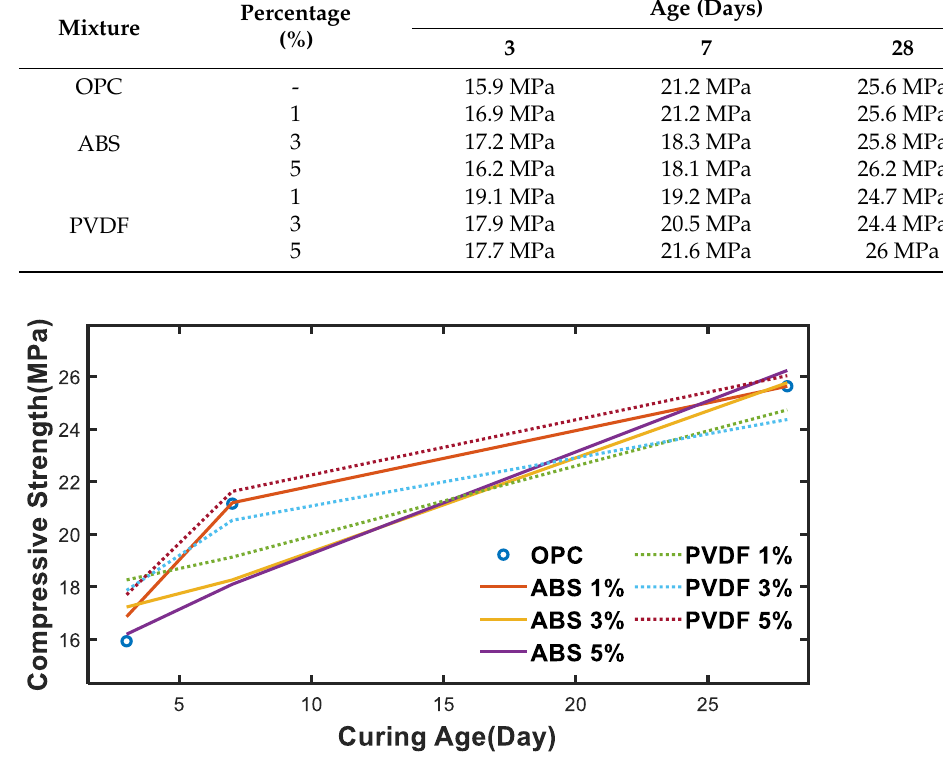
Figure 12. Comparison of compressive strength of specimens.